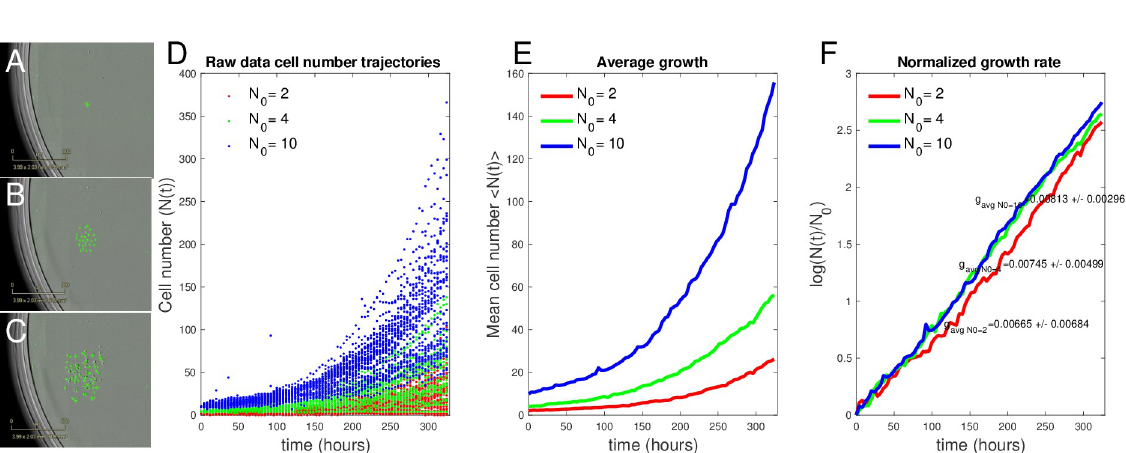
Fig 6. BT-474 cancer cells in culture exhibit growth rate scaling with initial cell density. (A, B, and C) Representative images from day 1 (A), day 6 (B), and day 14 (C) of BT-474 GFP labeled cells proliferating in vitro. (D) Individual cell-number trajectories for different N 0 = 2, 4, and 10. (E) Average cell number every 4 hours from each trajectory of N 0 = 2, 4, and 10. (F) Cell number in time normalized by initial cell number in log scale reveals scaling of growth rate by initial cell number, with g = 0.00665 ± 0.00684, 0.00745 ± 0.00499, and 0.00813 ± 0.00296 for N 0 = 2, 4, and 10, respectively.The data and code used to generate this figure can be found at https://github.com/brocklab/Johnson- AlleeGrowthModel.git.